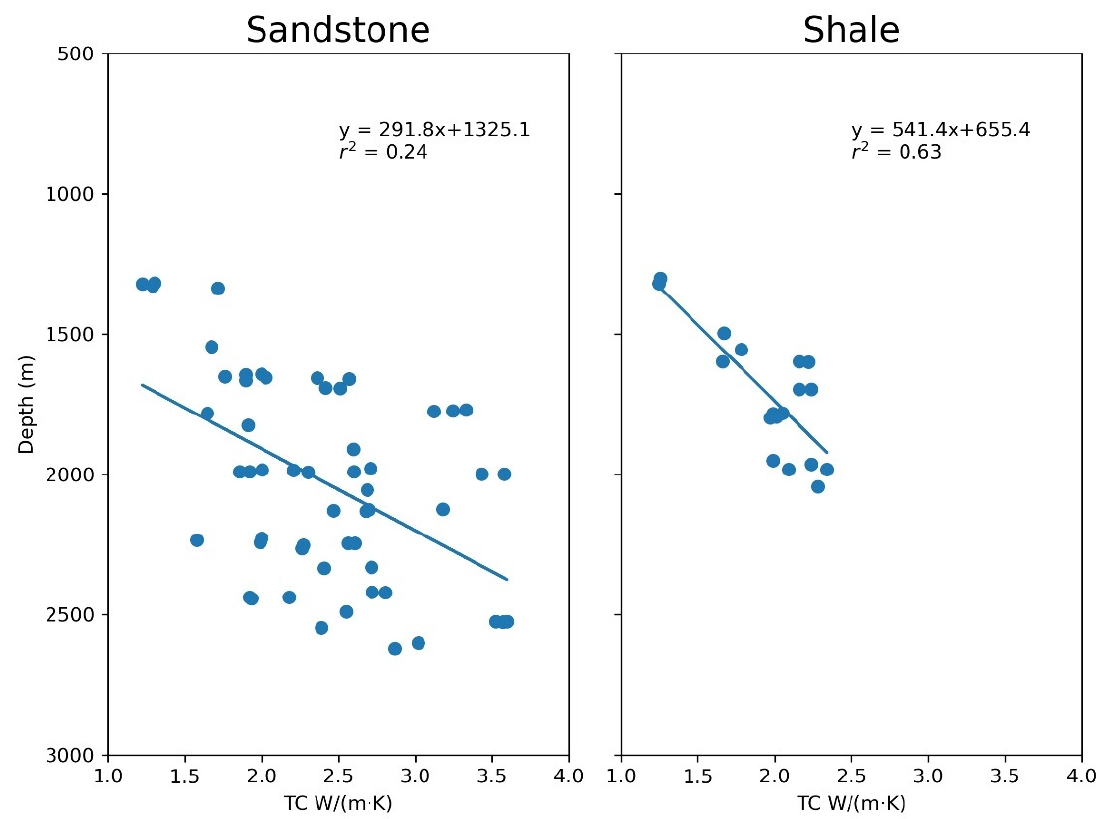
Figure 1. Thermal conductivity histograms obtained from the laboratory testing, note that the frequency has been normalized.